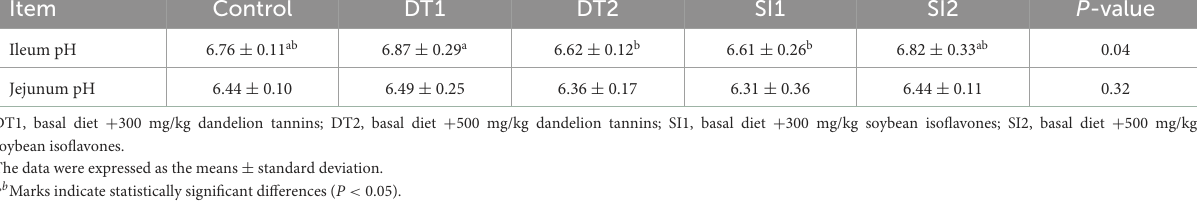
TABLE 6 Effects of dietary supplementation with dandelion tannins or soybean isoflavones on jejunum and ileum histomorphology of Wenchang chickens.